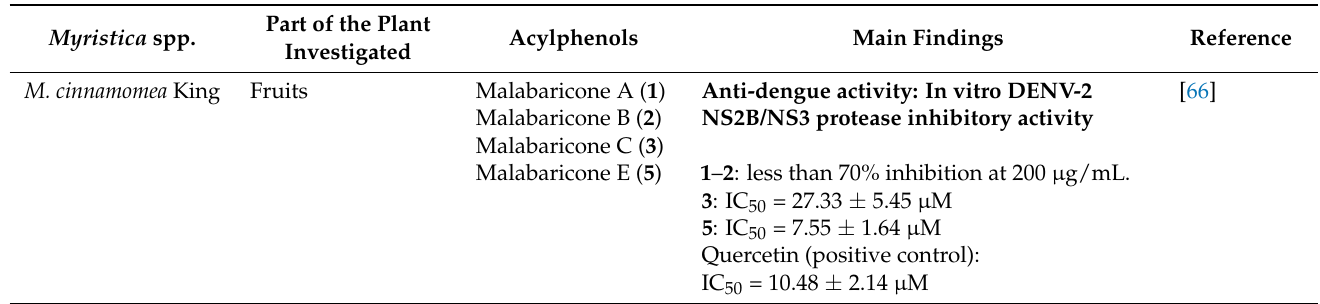
Table 13. The anti-dengue activity of acylphenols from the genus Myristica . Myristica